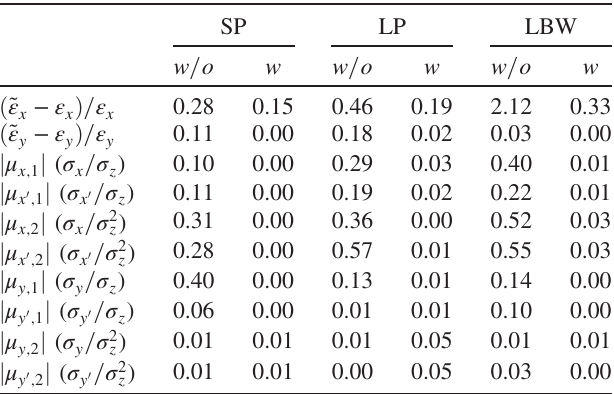
TABLE V. The three main operation modes for SwissFEL to benchmark the correction algorithm are described in Table I. This table shows the reduction of emittance growth as well as the beam tilt for all operation modes. The direction x stands for the bending plane.